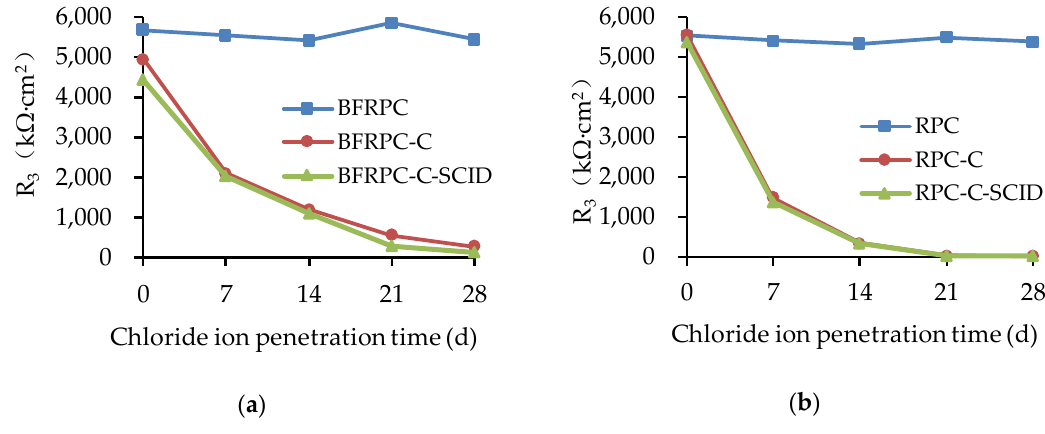
Figure 11. Polarization resistance R 3 for: ( a ) BFRPC specimens; ( b ) RPC specimens.